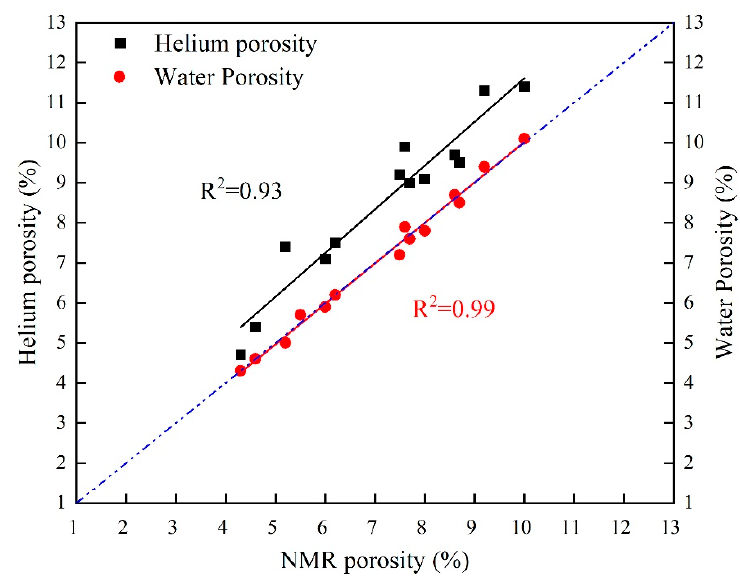
Fractal Fract. 2023 , 7 , 57 Figure 5. Correlations of helium porosity vs. NMR porosity and water porosity. Figure 5. Correlations of helium porosity vs. NMR porosity and water porosity.